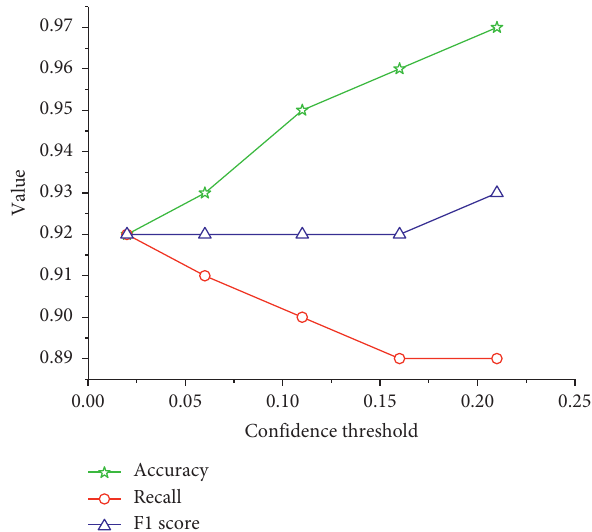
Figure 7: Performance comparison of fusion detection algorithm.